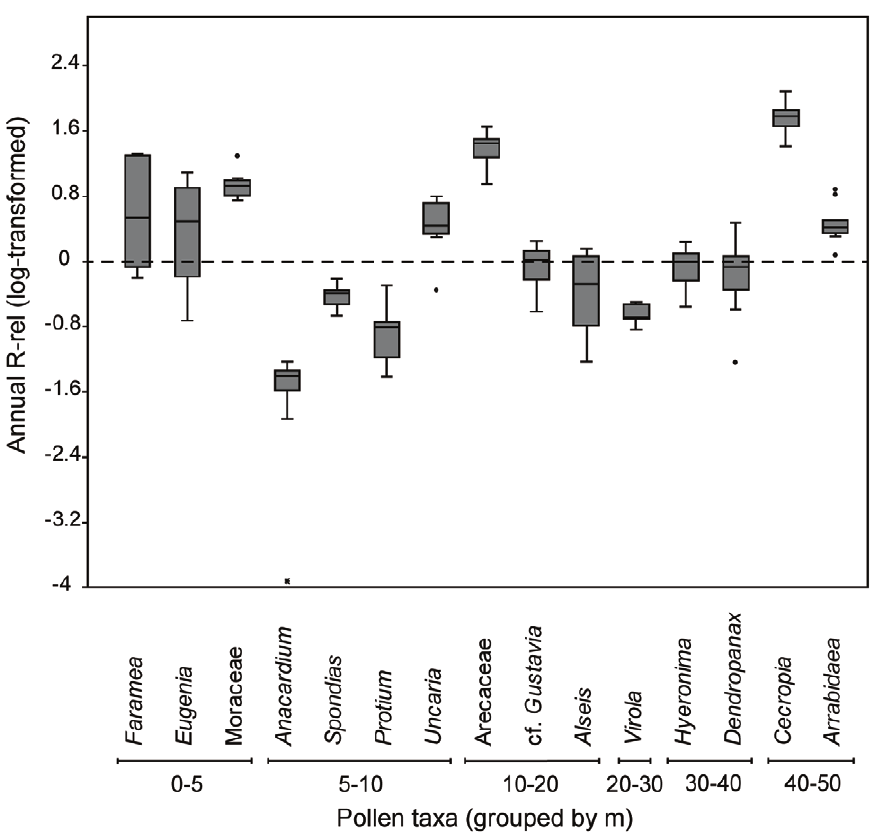
Figure 2. Annual variability in R-rel from 1996–2005. Variability in log-transformed annual R-rel values for 15 of the most abundant pollen taxa with corresponding basal area estimates. Taxa with values . 0 are overrepresented and values , 0 are underrepresented. Taxa are grouped according to distance to nearest individual at reproductive DBH from the base of Lutz tower (in m). Taxa within 5 m of the traps demonstrate some of the highest and most variable R-rel values.